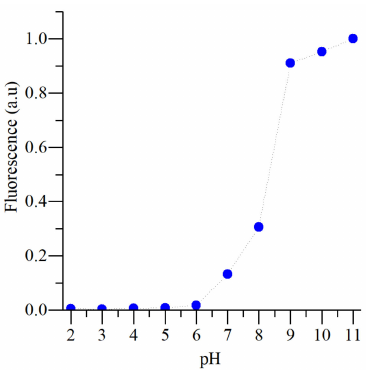
Figure 7. Plot of fluorescence intensity variation with pH of 4MU (0.1 mM), for λ excitation = 365 nm and λ emission = 450 nm, obtained using a